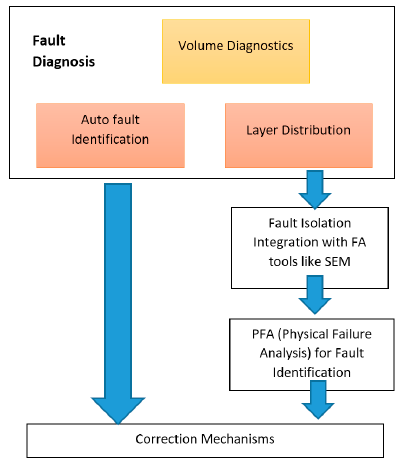
Figure 1. Flow of failure analysis for yield improvement.